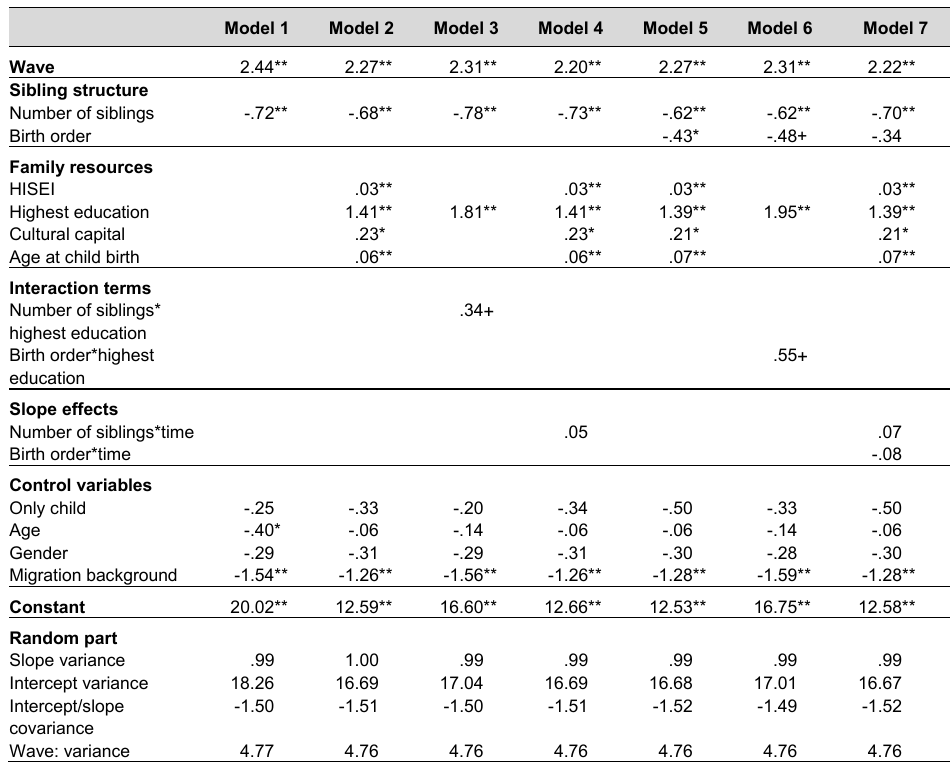
Table 2 : Linear latent growth curve models (LGMs) on vocabulary test scores (wave 1-3): Number of siblings and birth